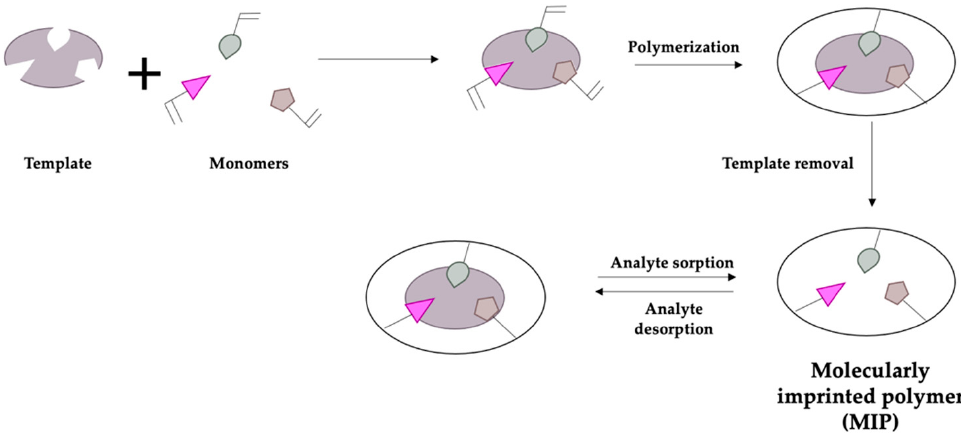
Figure 1. Schematic representation of molecularly imprinting procedure to form a MIP.